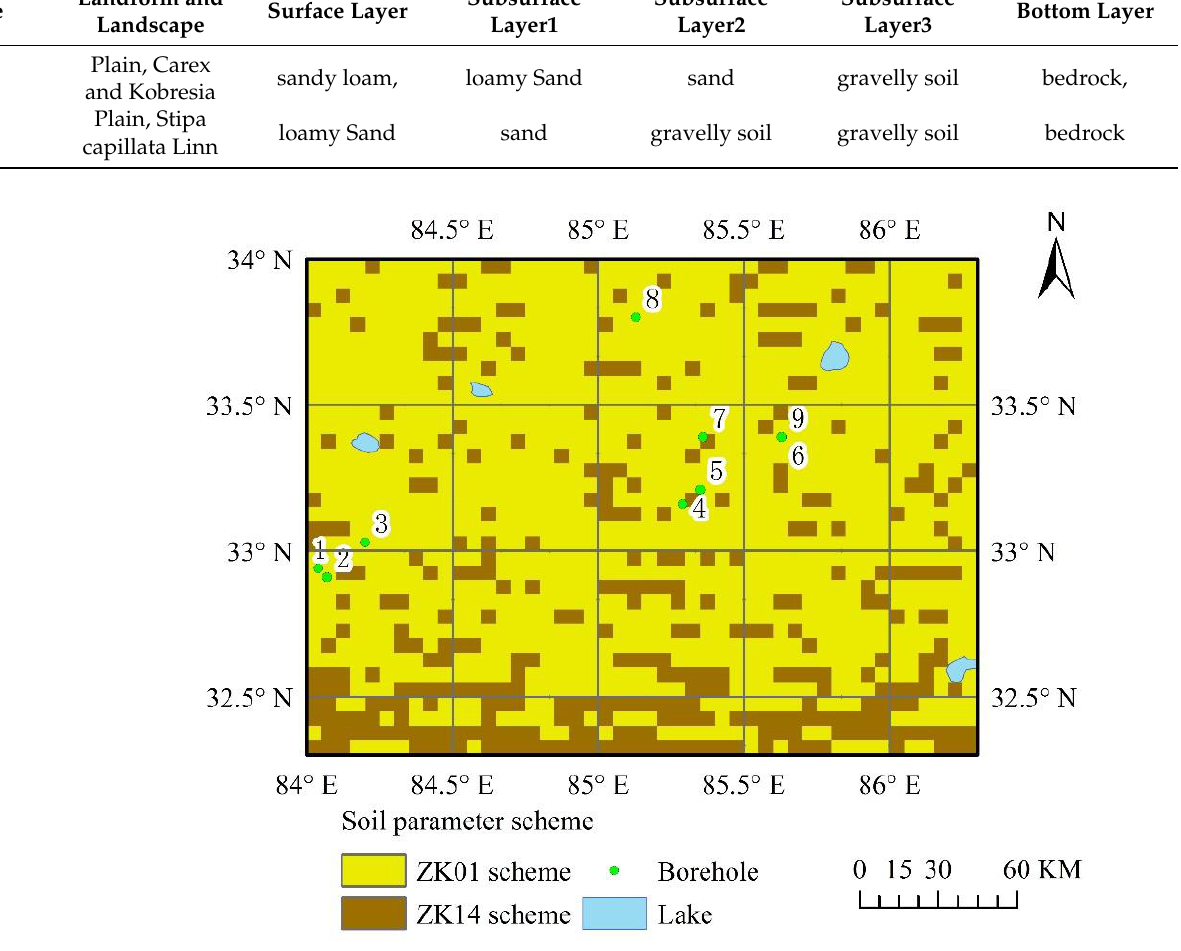
Table 2. Landscape and soil profiles of the two soil parameter schemes of the Gaize area.